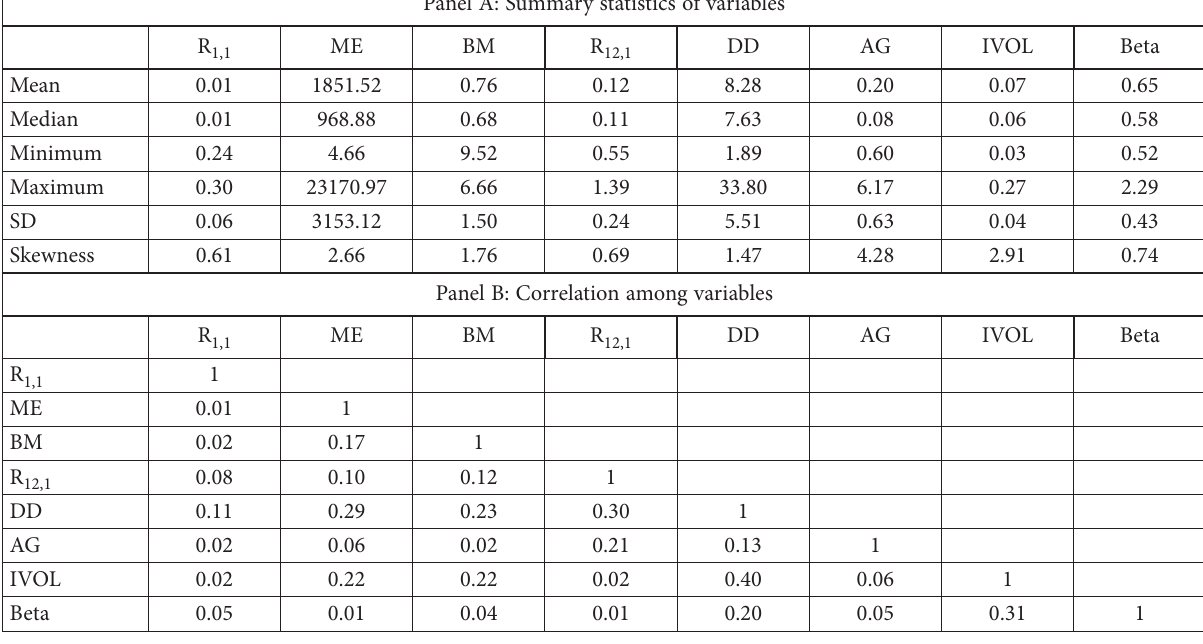
Panel A: Summary statistics of